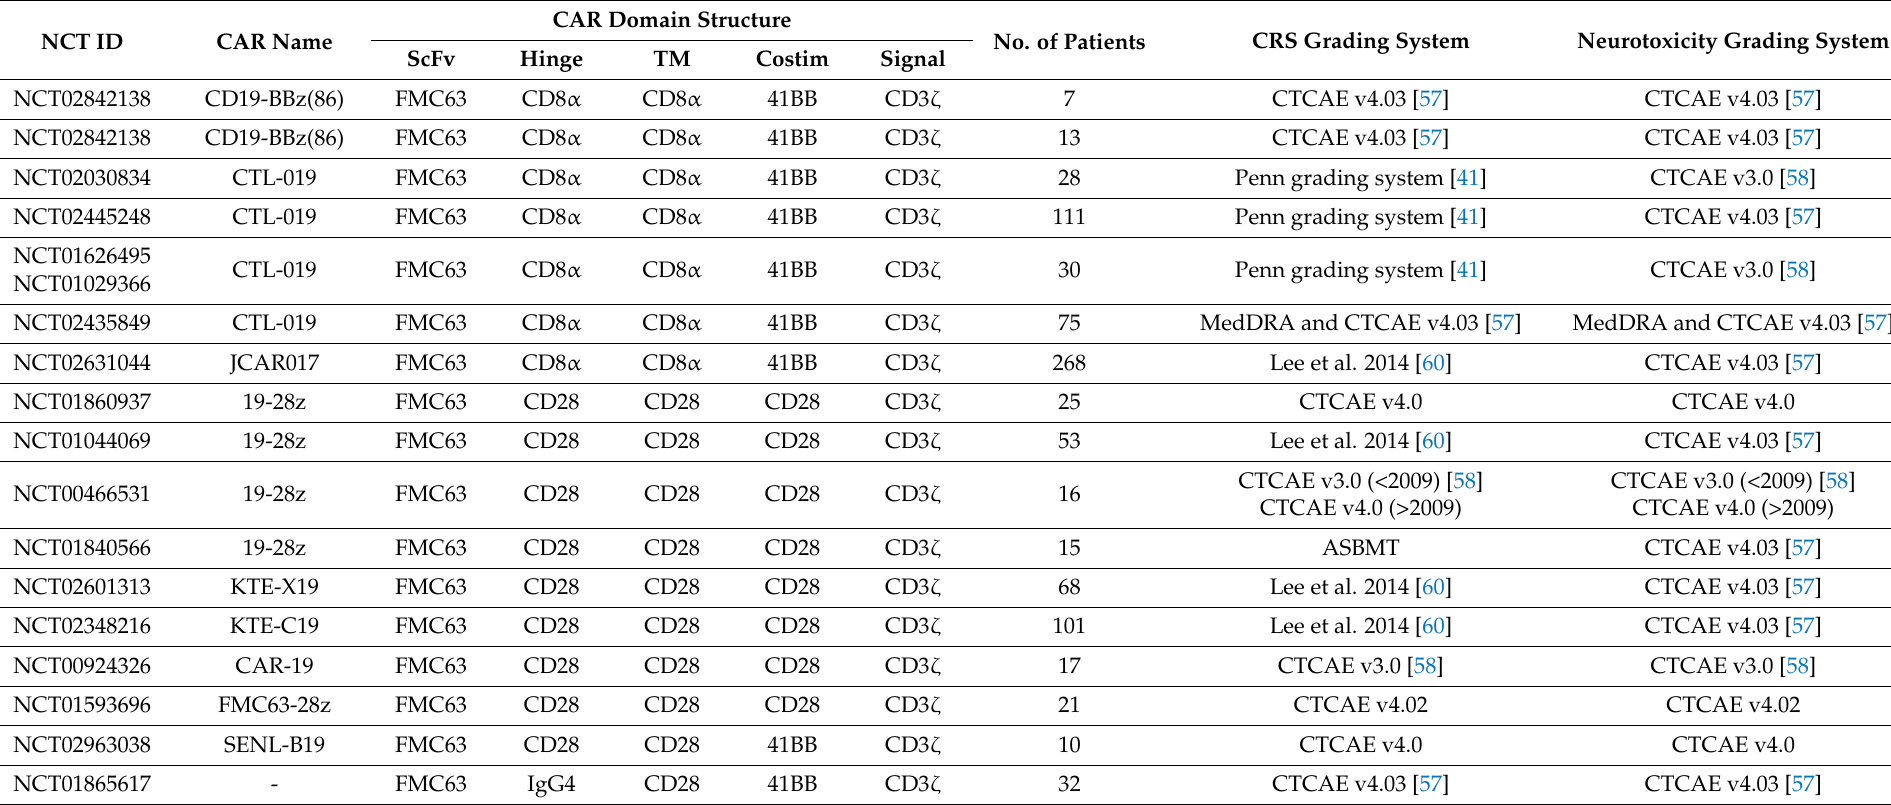
Table 3. CRS grading systems used in published FMC63 (CD19) CAR-T cell clinical